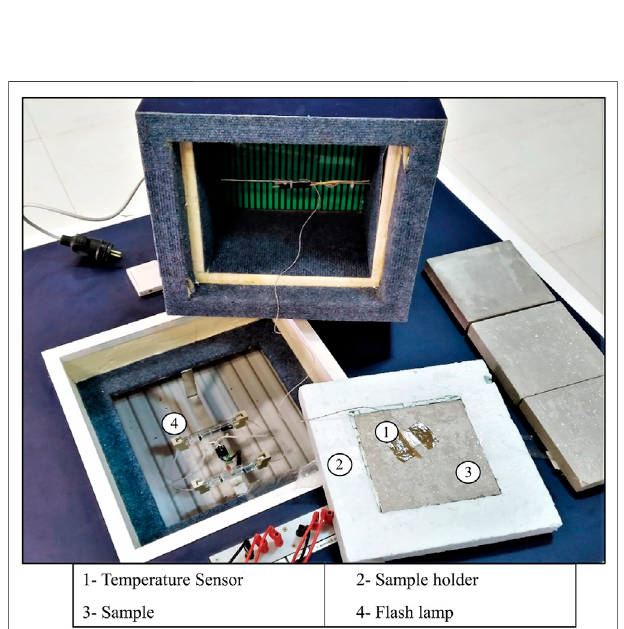
FIGURE 5 | Density versus EPS beads